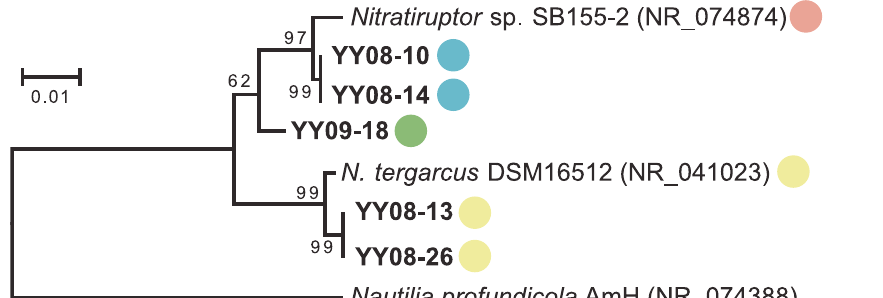
Fig. 1 A maximum-likelihood phylogenetic tree based on almost complete 16 S rRNA gene sequences of representative members of the genus Nitratiruptor using 1408 to 1420 nucleotides. Bootstrap analysis was performed with 100 repetitions. Boldface type indicates Nitratiruptor strains obtained in this study. Each strain was color-coded based on the species-level-de fi nition (95%) of ANI identity. GenBank accession numbers of 16 S rRNA gene sequences are given in parentheses. Nautilia profundicola AmH was used as an outgroup. The scale bar indicates a 0.01 change per nucleotide.